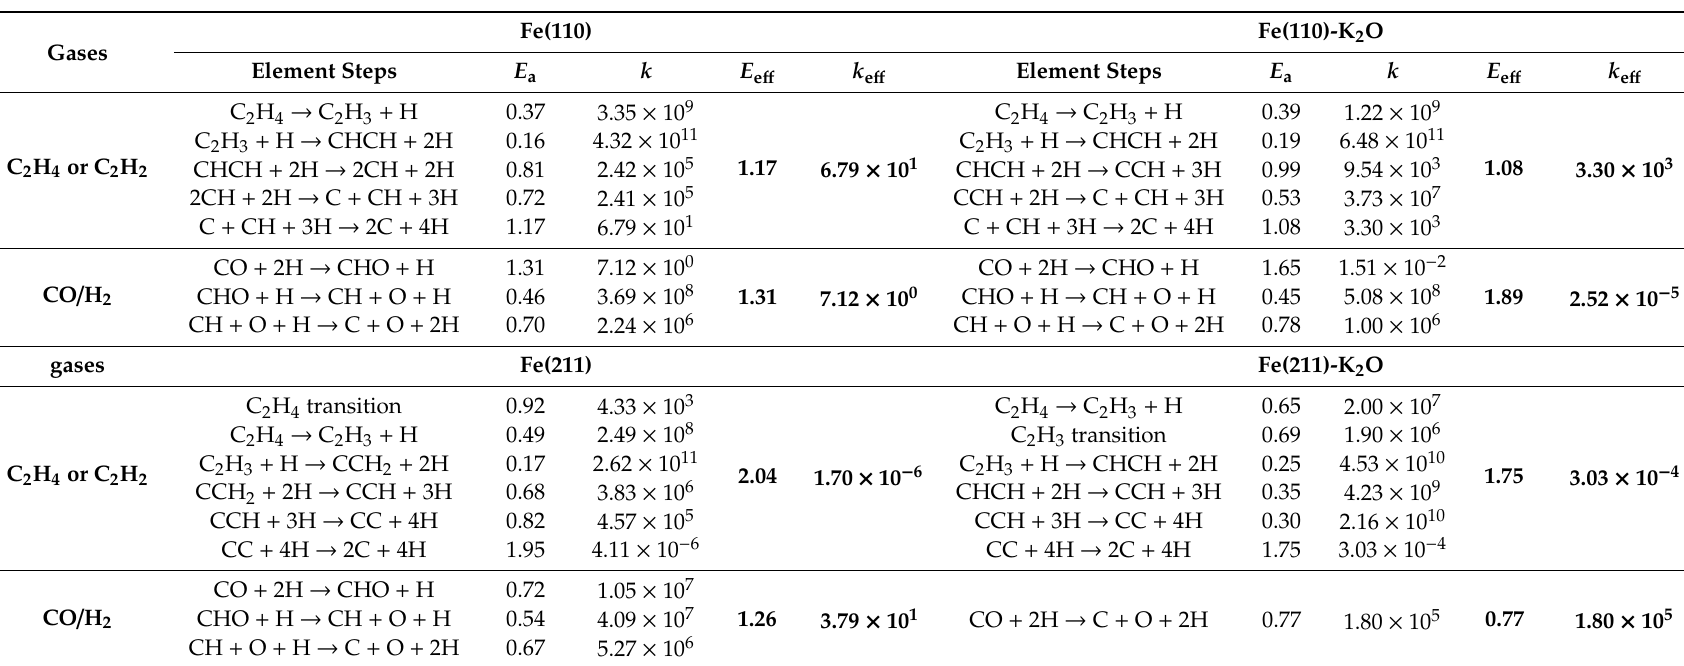
Table 3. The barriers ( E a , eV) of the element steps for C 2 H 4 and CO / H 2 dissociation, the rate constants ( k , s − 1 ) at the temperature of 600K, as well as the total e ff ective barriers (red boldface) and rate constants (blue boldface) of C 2 H 4 / C 2 H 2 and CO / H 2 dissociation on Fe(110), Fe(110)-K 2 O, Fe(211) and Fe(211)-K 2 O